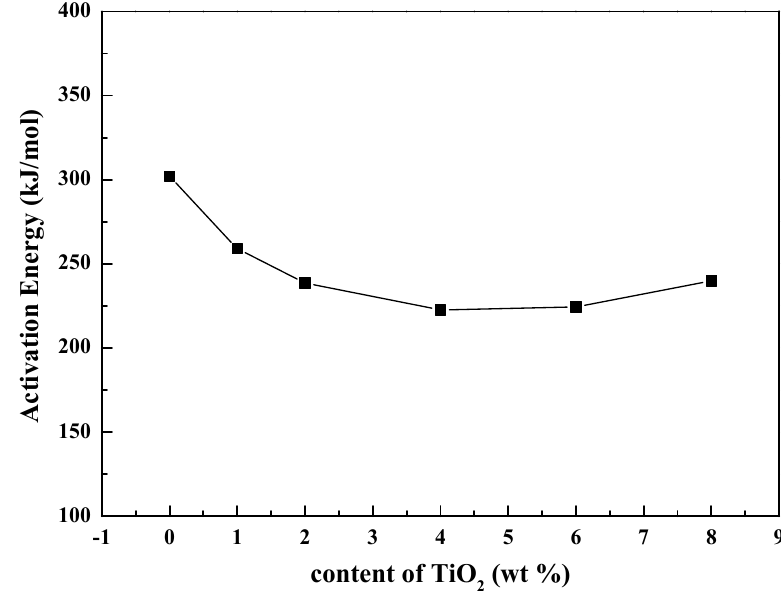
Figure 6. The change in the activation energy of crystallization with di ff erent contents of TiO 2 . Table 2. Calculated results of the Avrami parameter (n) of di ff erent